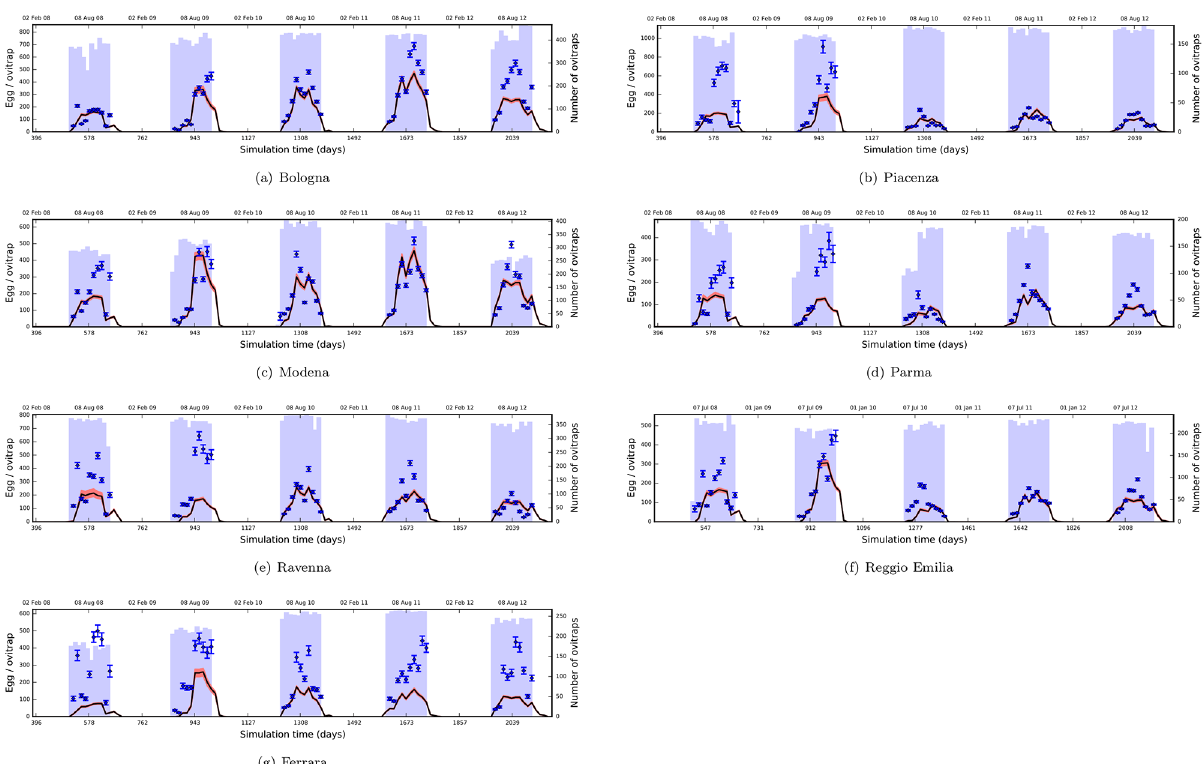
Fig 3. Performance evaluation against the surveillance data from Emilia-Romagna. Blue diamonds represent average egg counts per ovitrap, and vertical error bars represent the standard error of the mean. They are positioned at the dates of data collection along the horizontal axis. Blue bars in the background indicate the number of ovitraps covering a period of two weeks prior to each collection. Solid black lines show model output using the parameters from Θ 1 (see text). Red shades represent the 95% confidence interval.